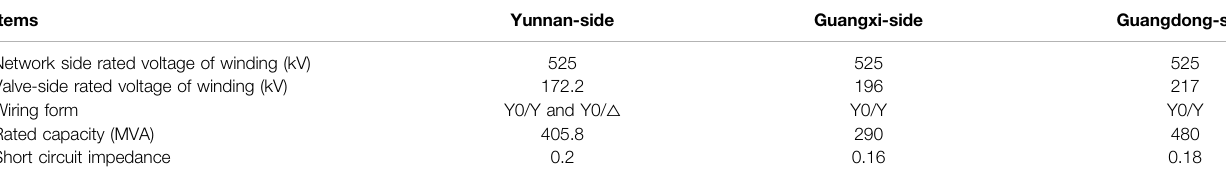
TABLE 1 | Converter transformer parameters.